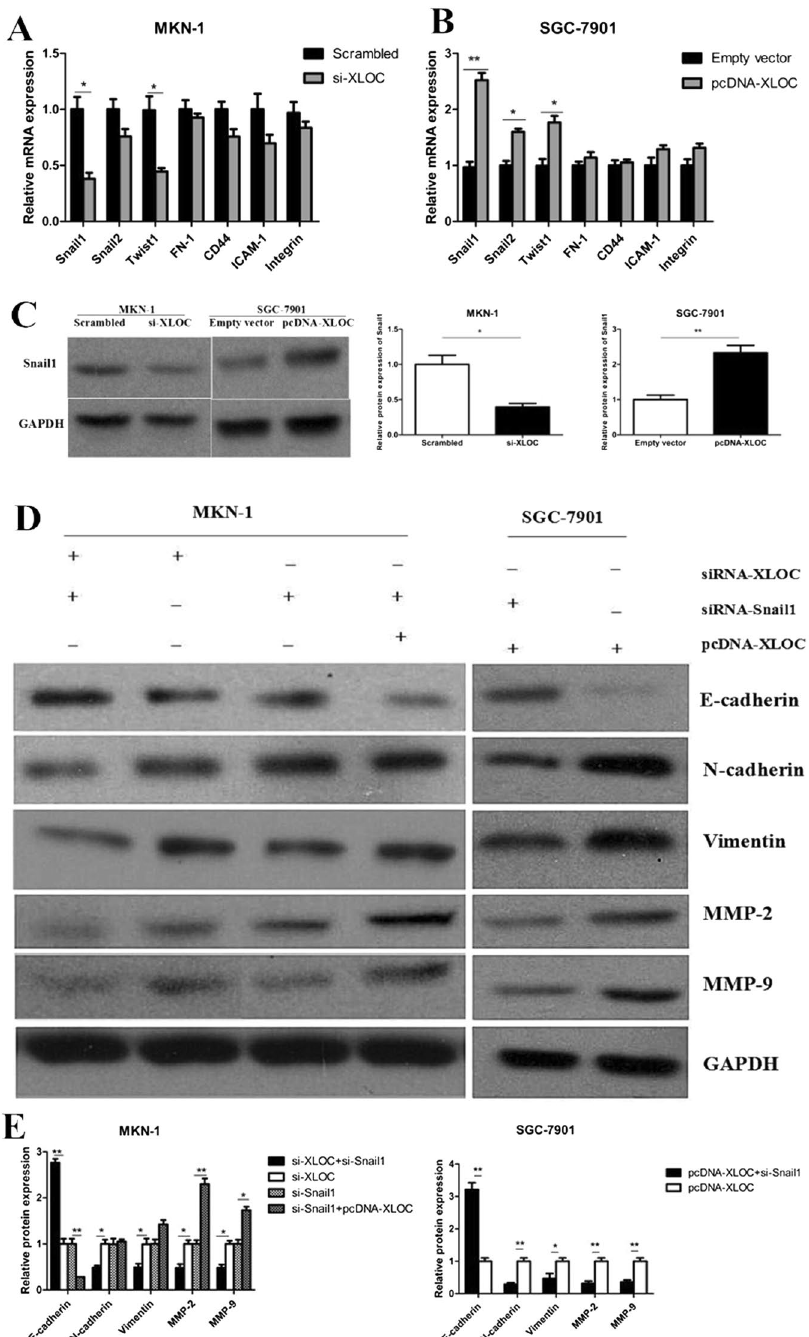
Figure 3. XLOC_010235 regulates Snail1 expression in affecting EMT. ( A ) Expression of EMT-related molecules (Snail1, Snail2, Twist1, FN-1, CD-44, ICAM-1, Integrin) detected using qRT-PCR after XLOC_010235 was blocked in MKN-1 cells or ( B ) over-expressed in SGC-7901 cells. ( C ) After XLOC_010235 expression is blocked in MKN-1 cells, western blot analysis shows that the Snail1 protein level is diminished, as compared to the level in the control group (left panel). The Snail1 protein level is elevated after XLOC_010235 is over-expressed in SGC-7901 cells, as compared to the level in the control group (right panel). ( D , E ) Analysis of E-cadherin, N-cadherin, Vimentin, MMP-2 and MMP-9 expression in MKN-1 cells following the treatment with si-XLOC_010235 + si-Snail1 compared to groups treated with si-XLOC_010235 alone, the treatment with pcDNA-XLOC_010235 + si-Snail1 compared to groups treated with si-Snail1 alone and in SGC-7901 cells following the treatment with pcDNA-XLOC_010235 alone compared to groups treated with pcDNA- XLOC_010235 + si-Snail1 by western blot. All the above experiments were performed in triplicate. Bars: SD; * p < 0.05 and ** p <